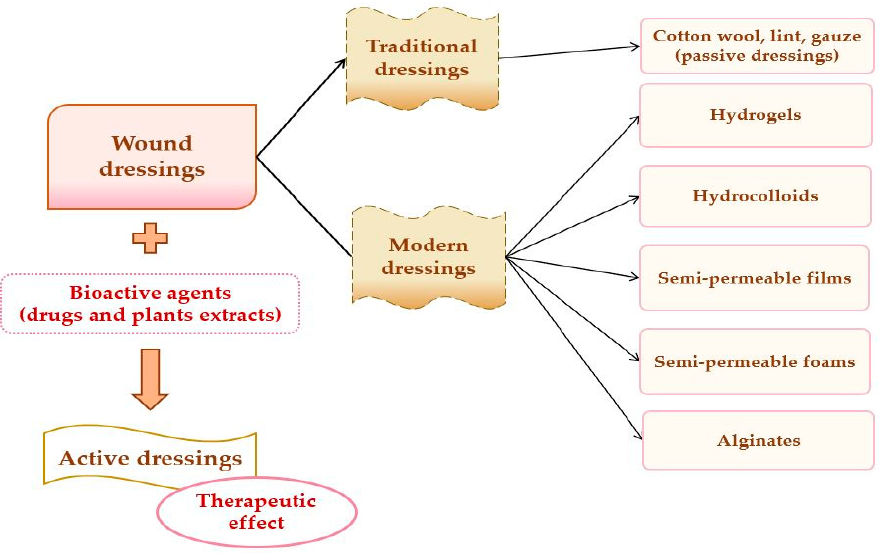
Figure 4. Wound dressings classification.